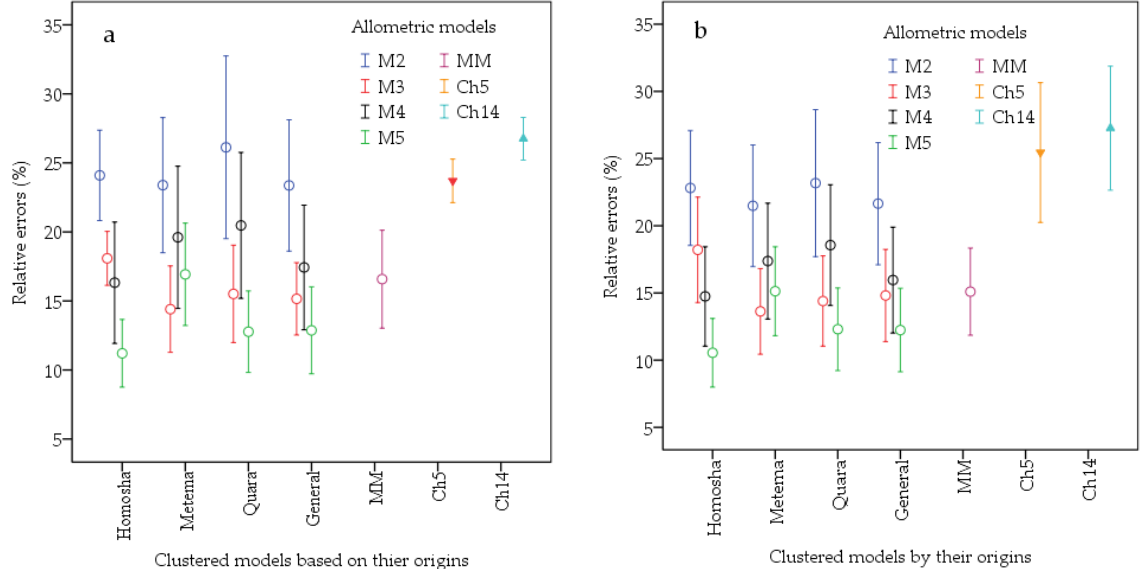
Figure 4. The relative errors in plot ( a ) and across-plot ( b ) AGB estimates result from combining the species in mixed-species models and using the distant models. The symbols of MM, Ch5, and Ch14 refer to the models of Mugasha and Chave, respectively, as defined in Section 2.6.1. The error bar indicates the 95% CIs of the mean. The best selected model (M4) that included wood density and DBH using fit statistics and testing data at tree level was not performing well when applying the plot and across- plot AGB estimates, except for the model of Homosha (Table 4). The model produced a